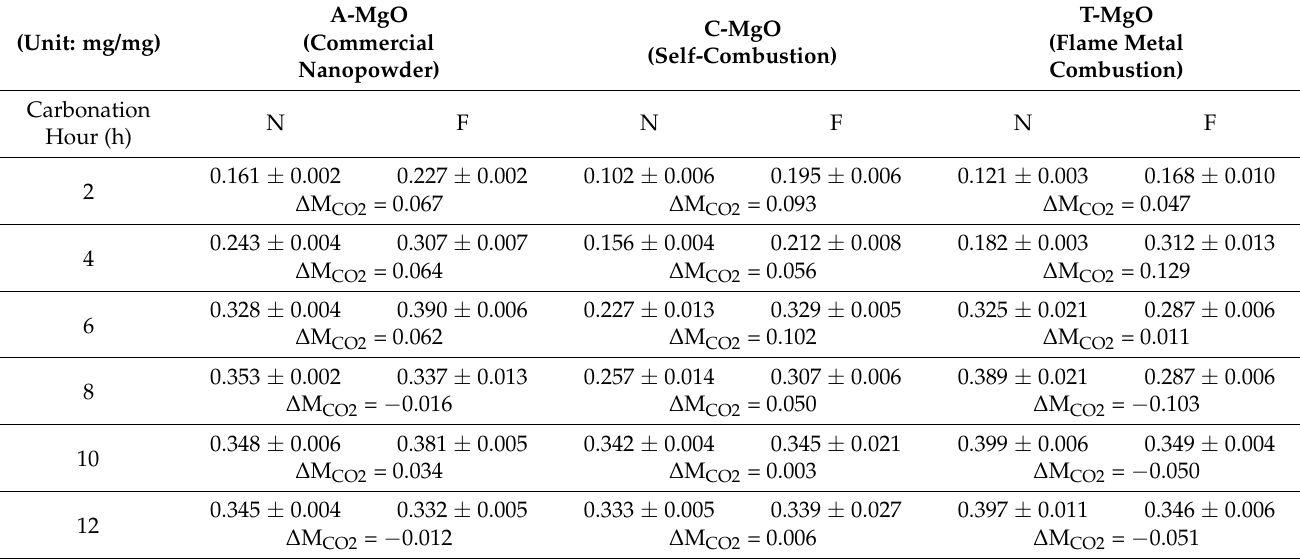
Table 3. Adsorbed CO 2 mass per unit mass of carbonated MgO samples (M CO2 ) (mg/mg) through GC-TCD analysis and the differences of M CO2 ( ∆ M CO2 ) between non-forced (N) and forced (F) wet carbonation